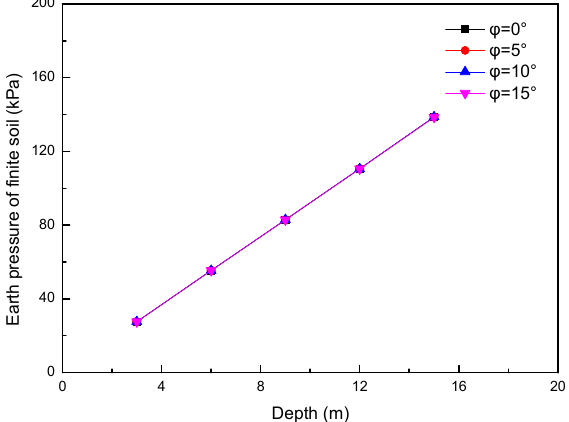
Figure 15. Influence of internal friction angle on earth pressure of finite soil.